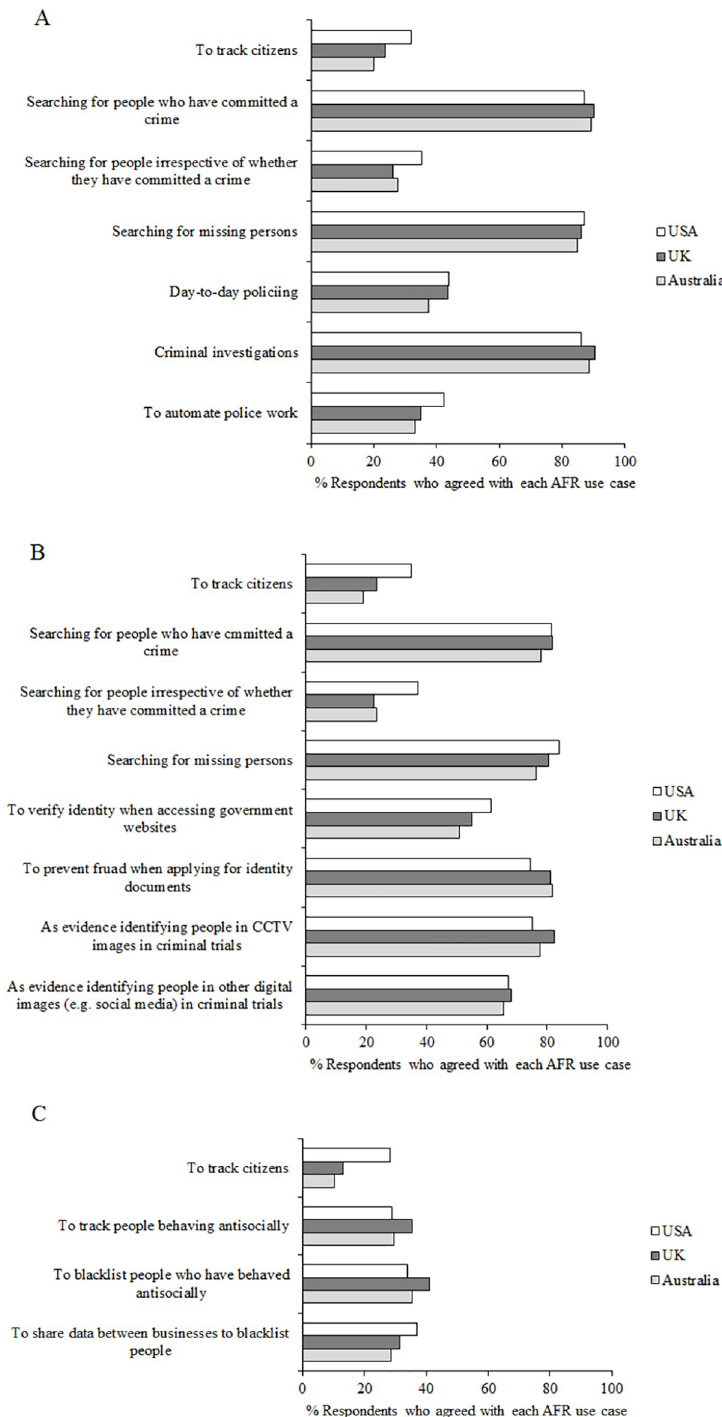
Fig 6. Questions 5–7 data. Percent of participants who agreed (responding 4, 5 or 6 on the scale of agreement) to questions 5–7 “To what extent do you agree with facial recognition technology being used by the police/the government/private companies in your country?” for each use case. A , police. B , government. C , private companies.